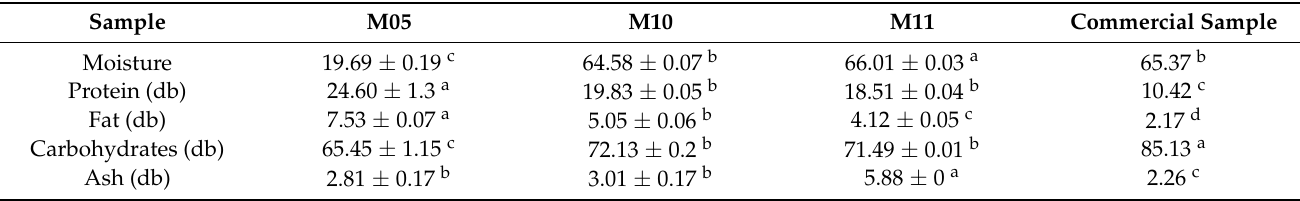
Table 4. Proximal composition of hamburger